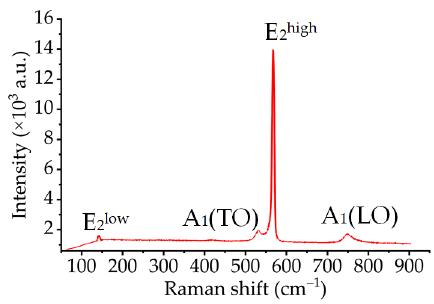
Figure 4. Raman spectrum of the (0001) plane GaN.